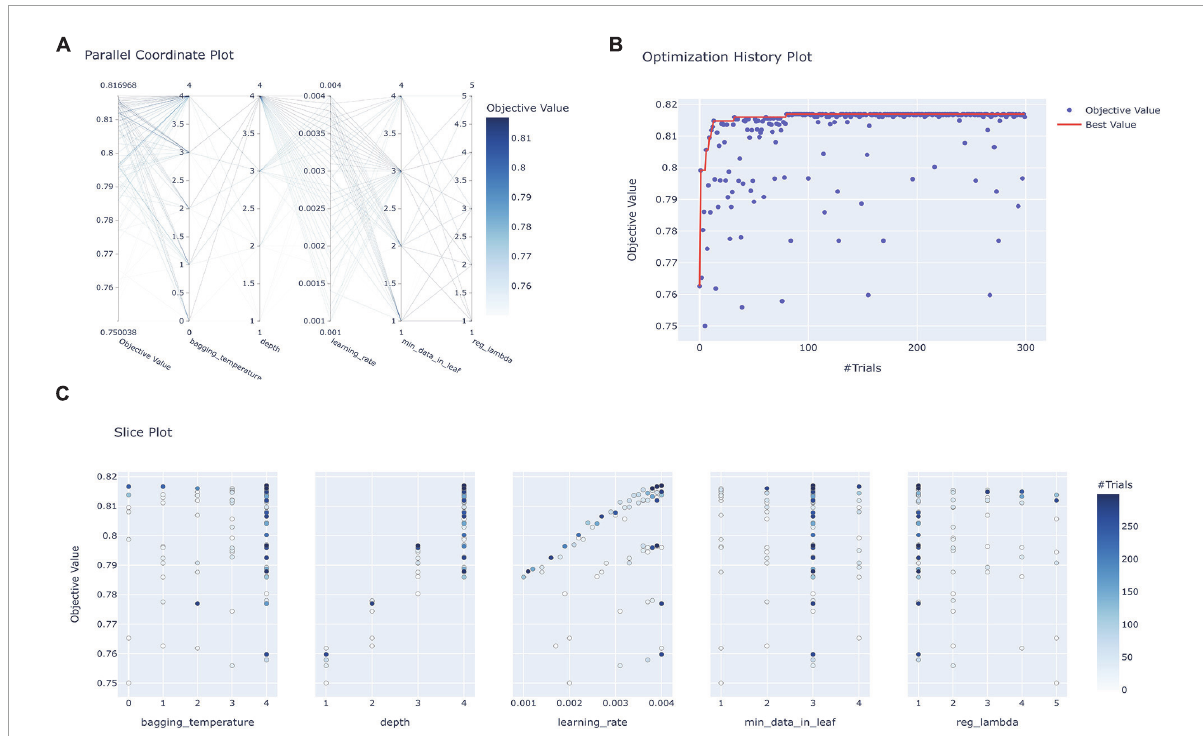
FIGURE2 Hyperparameter optimization process for the Catboost model. (A) Parallel coordinate system plot of the hyperparametric distribution corresponding to different levels of AUC values, where darker colors correspond to greater AUC values; (B) optimization history plot illustrating the evolution of optimal values during hyperparameter optimization; (C) slice plot visualizing the correlation between each parameter and the AUC. CatBoost, categorical